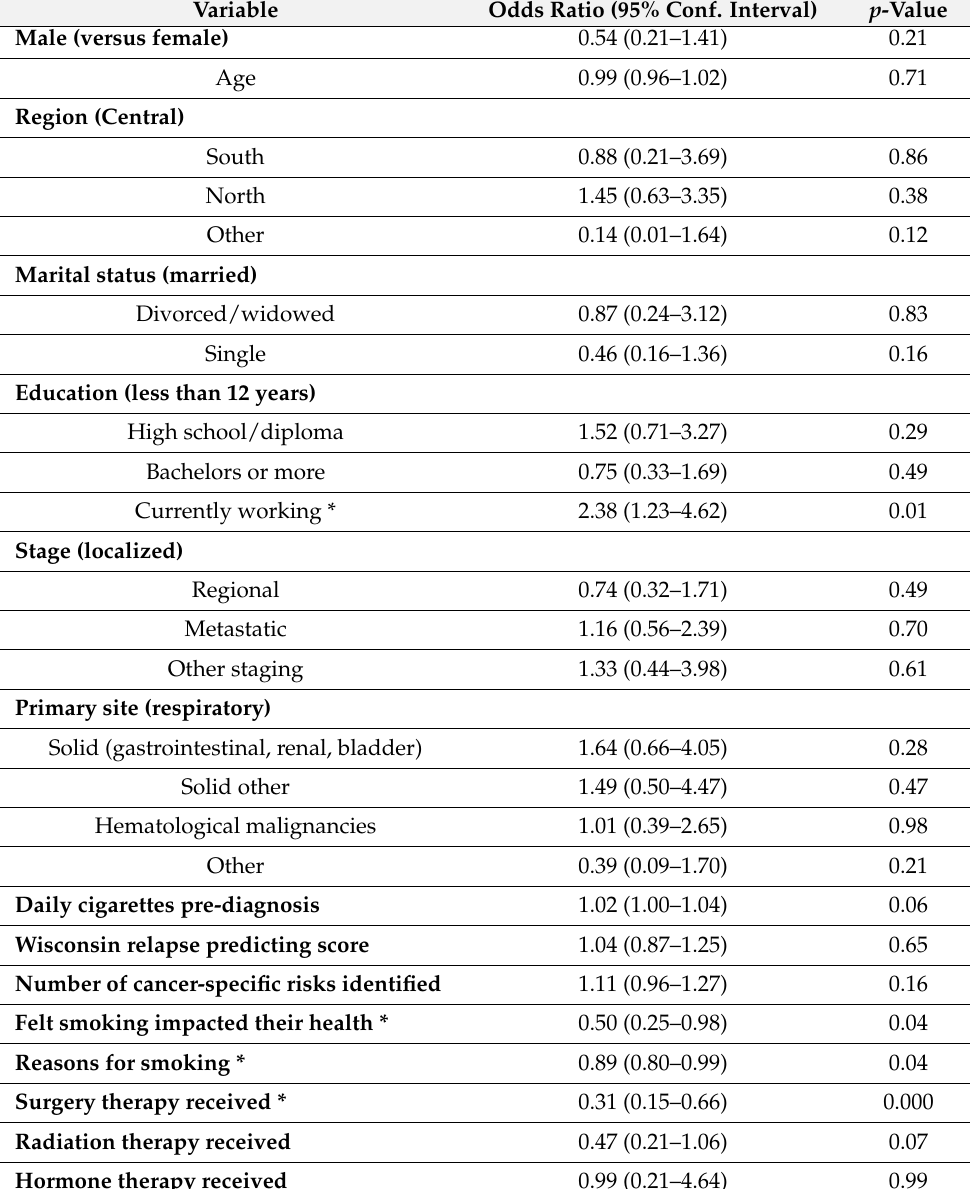
Table 3. Multivariable logistic regression predicting the odds of being a current smoker (relative to quitting or being in the process of quitting) across various patient-related factors. Variable Odds Ratio (95% Conf. Interval) p